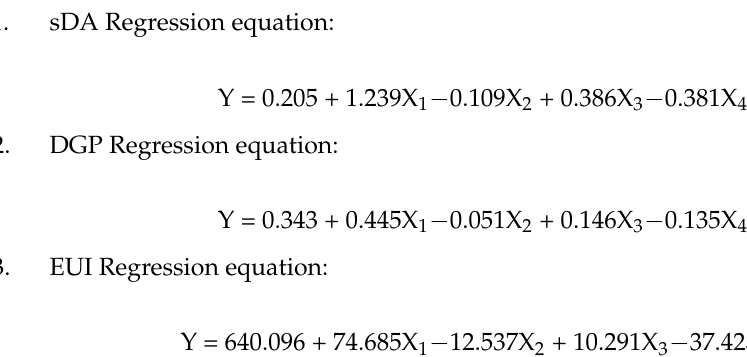
Figure 19. Sensitivity analysis of fabric shading commercial atrium SAS design